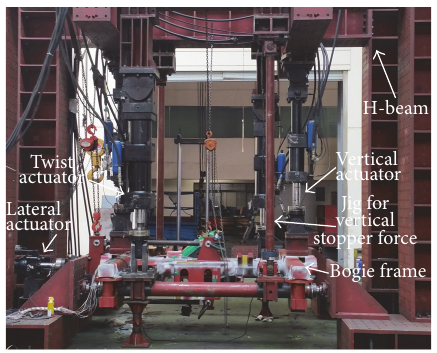
Figure 7: Equipment and specimen for fatigue